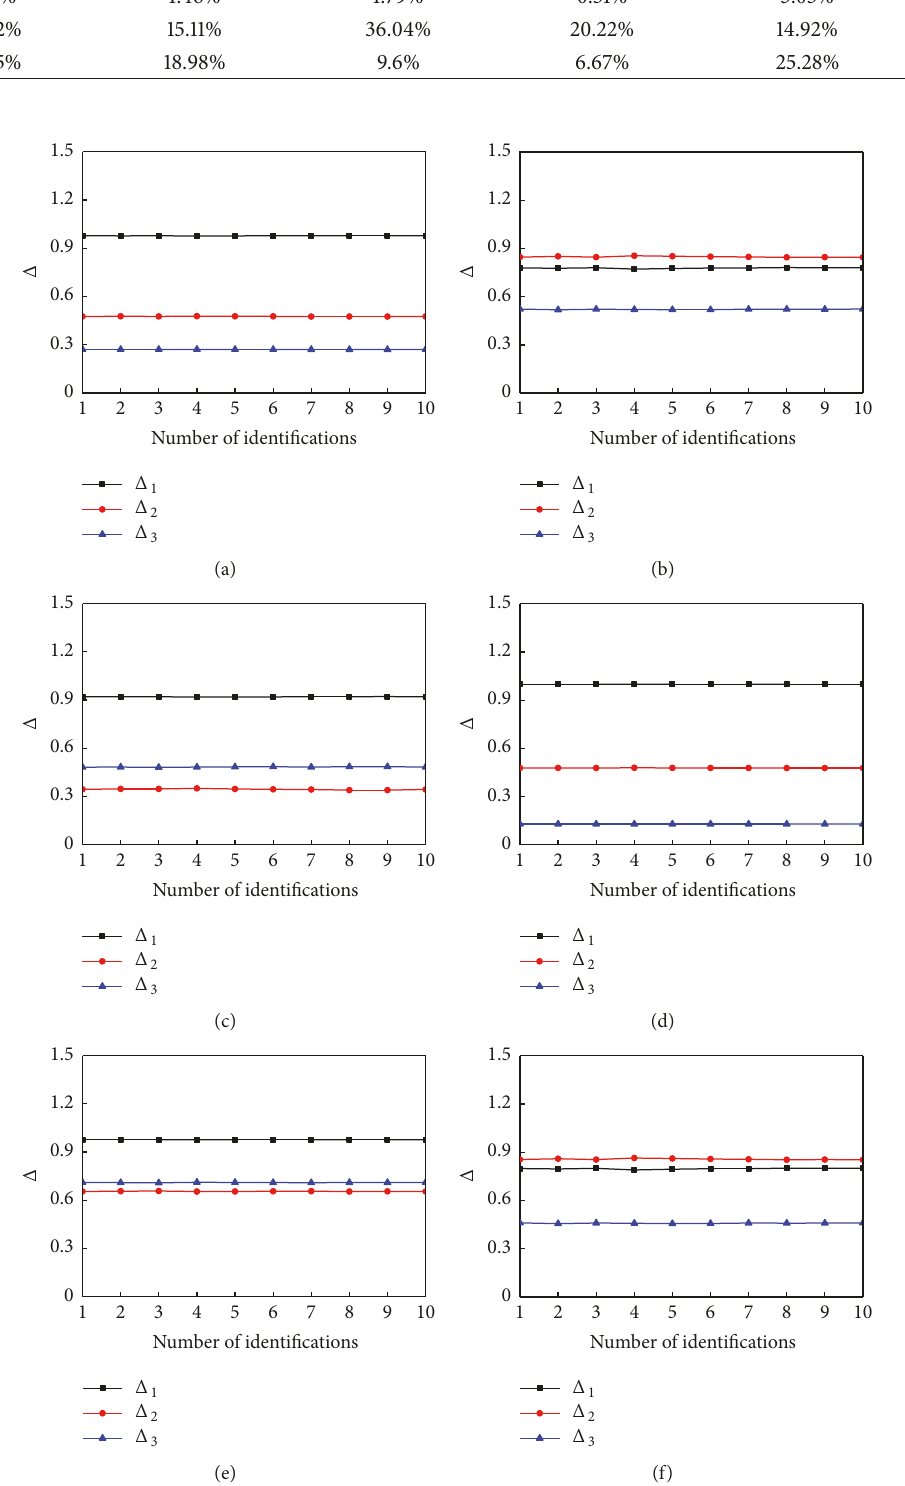
Figure 4: Δ value with different sensor placement. (a) Sensor set 1. (b) Sensor set 2. (c) Sensor set 3. (d) Sensor set 4. (e) Sensor set 5. (f) Sensor set